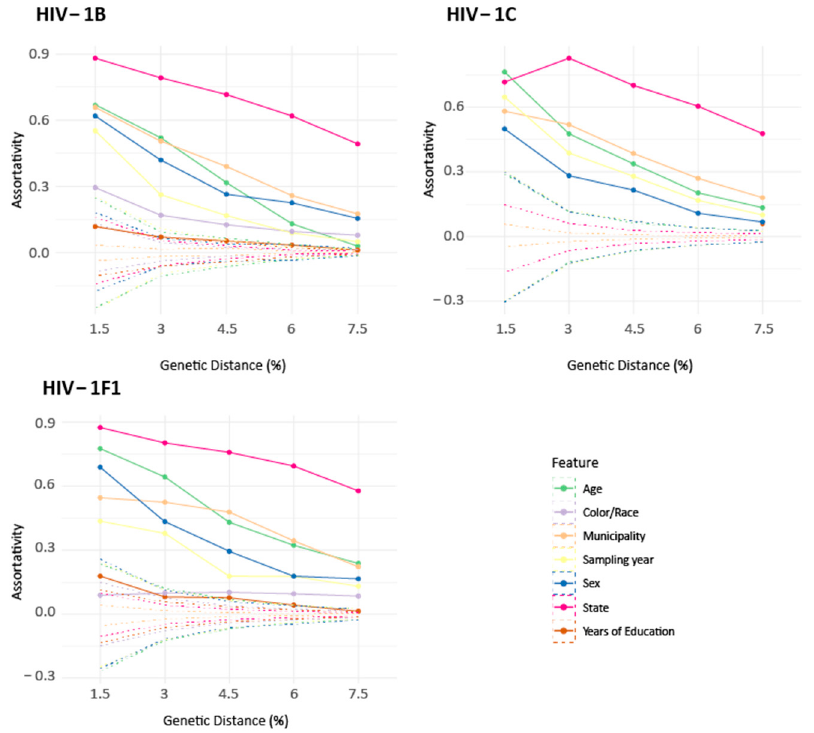
Figure 2. Assortativity coefficient for patients’ demographic features in same phylogenetic clusters. Assortativity (solid lines) and the null distribution (dashed lines) were calculated in clusters identified for HIV-1B, HIV-1C and HIV-1F1 in five different genetic distances.